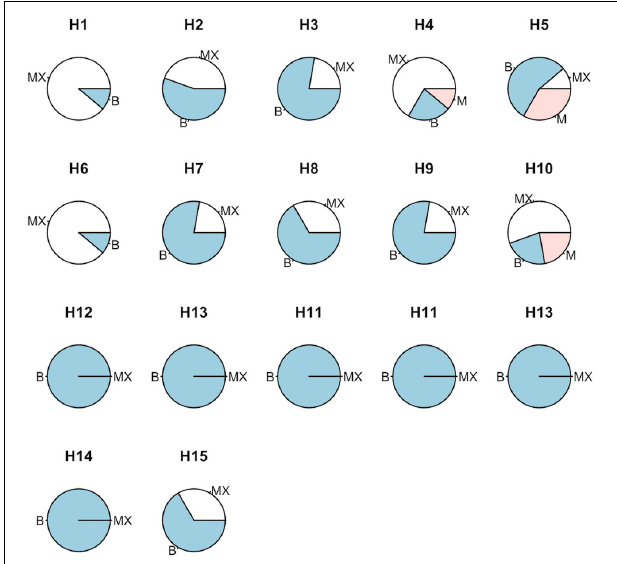
FIGURE 3 | Flake morphology assessment of QPP and ConAgra elite lines. Random samples of QPP and ConAgra lines from each experimental plot were given a description of butterfly (B—blue), mushroom (M—red), or mixed flake morphology (MX—white). Each cultivar was assigned a total of nine descriptions (three from each of the three locations). All ConAgra varieties were assigned butterfly morphology except H15, which was assigned three MX morphologies. QPP BC 2 -derived hybrids are displayed on the first row, respective QPP BC 3 -derived hybrids are on the second row, and original popcorn hybrids from the respective pedigrees are arranged on the third row to enable column comparison between similar QPP and ConAgra pedigrees. Commercial lines H14 and H15 are positioned on the fourth